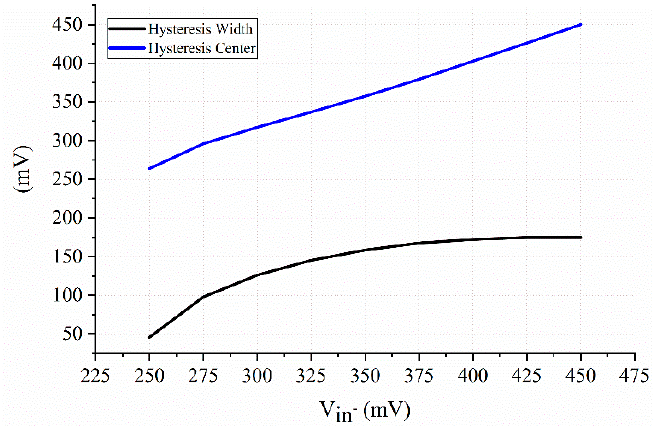
Figure 13. Variation of the hysteresis width and its center versus reference voltage of V in − while V C1 is set to 300 mV.